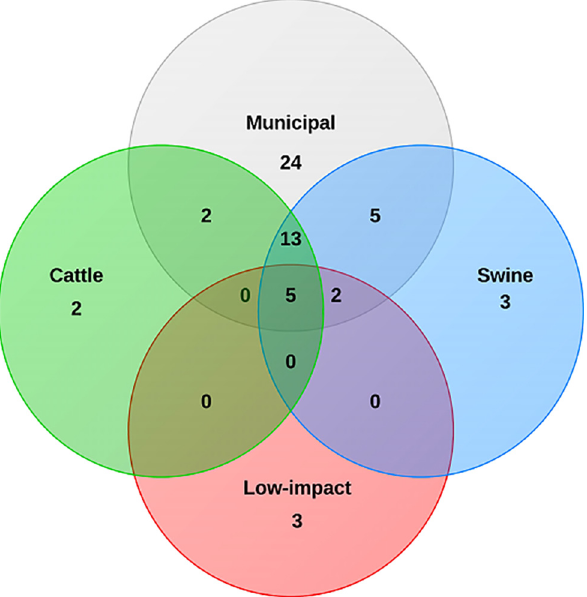
Fig 2. Venn diagram showing the number of specific genes identified by sample source. One gene common to cattle and swine samples and one gene common to low impact and municipal samples were not shown on the Venn diagram. The two genes are common to circles that cannot intersect in this